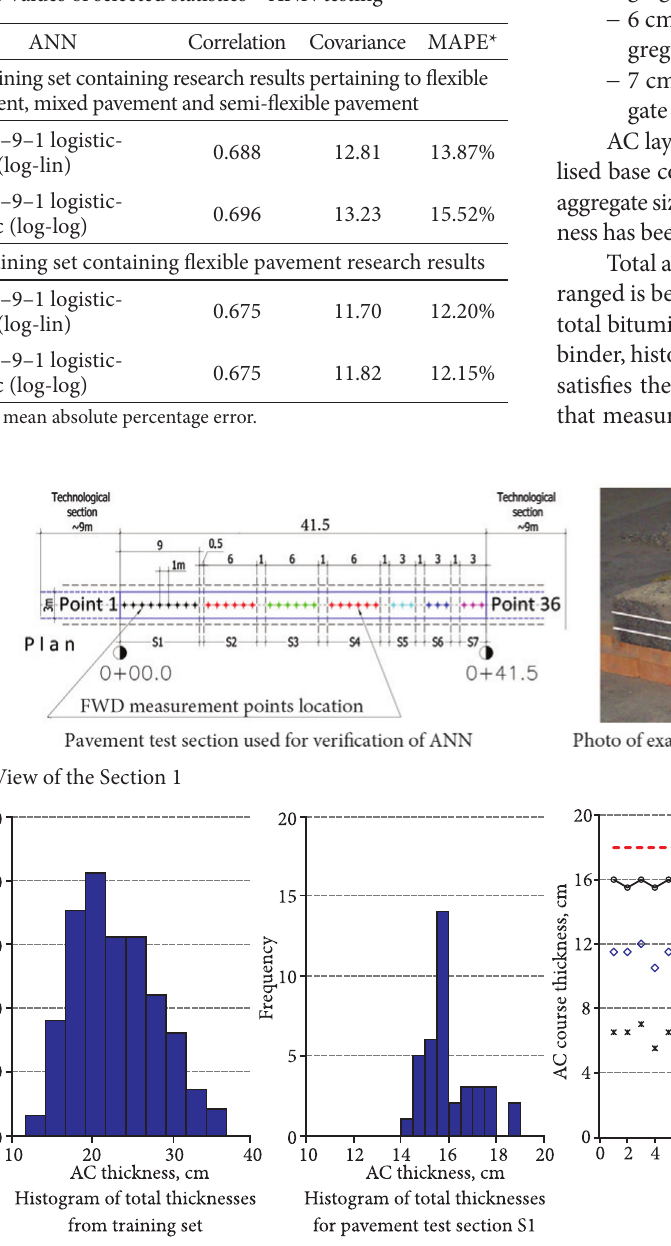
Fig. 4. Thickness of bituminous